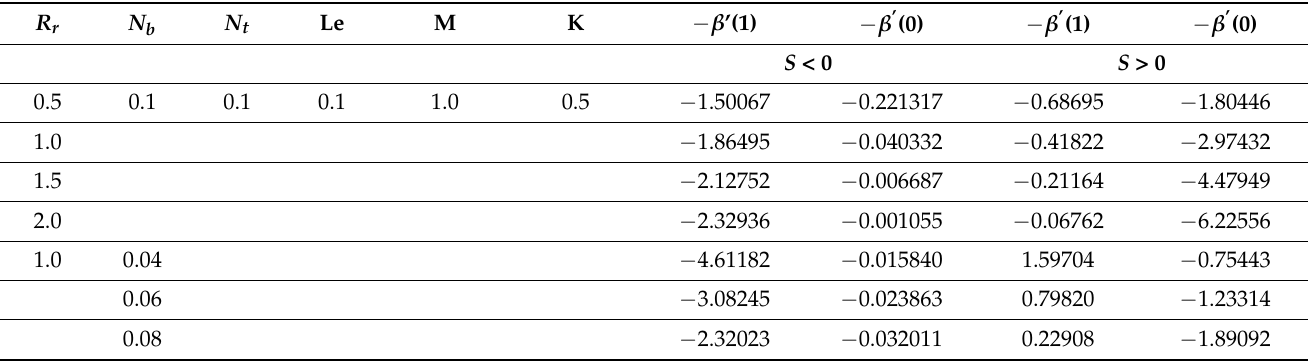
Table 10. Local Sherwood number for γ Al 2 O 3 − H 2 O at lower and upper plane with strong interac- tion n =